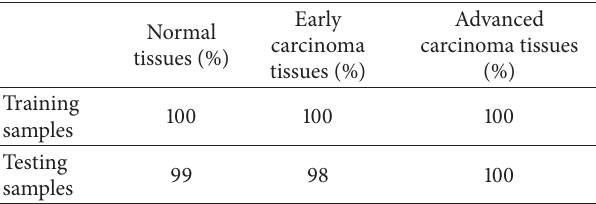
Table 1: Recognition results of probability neural